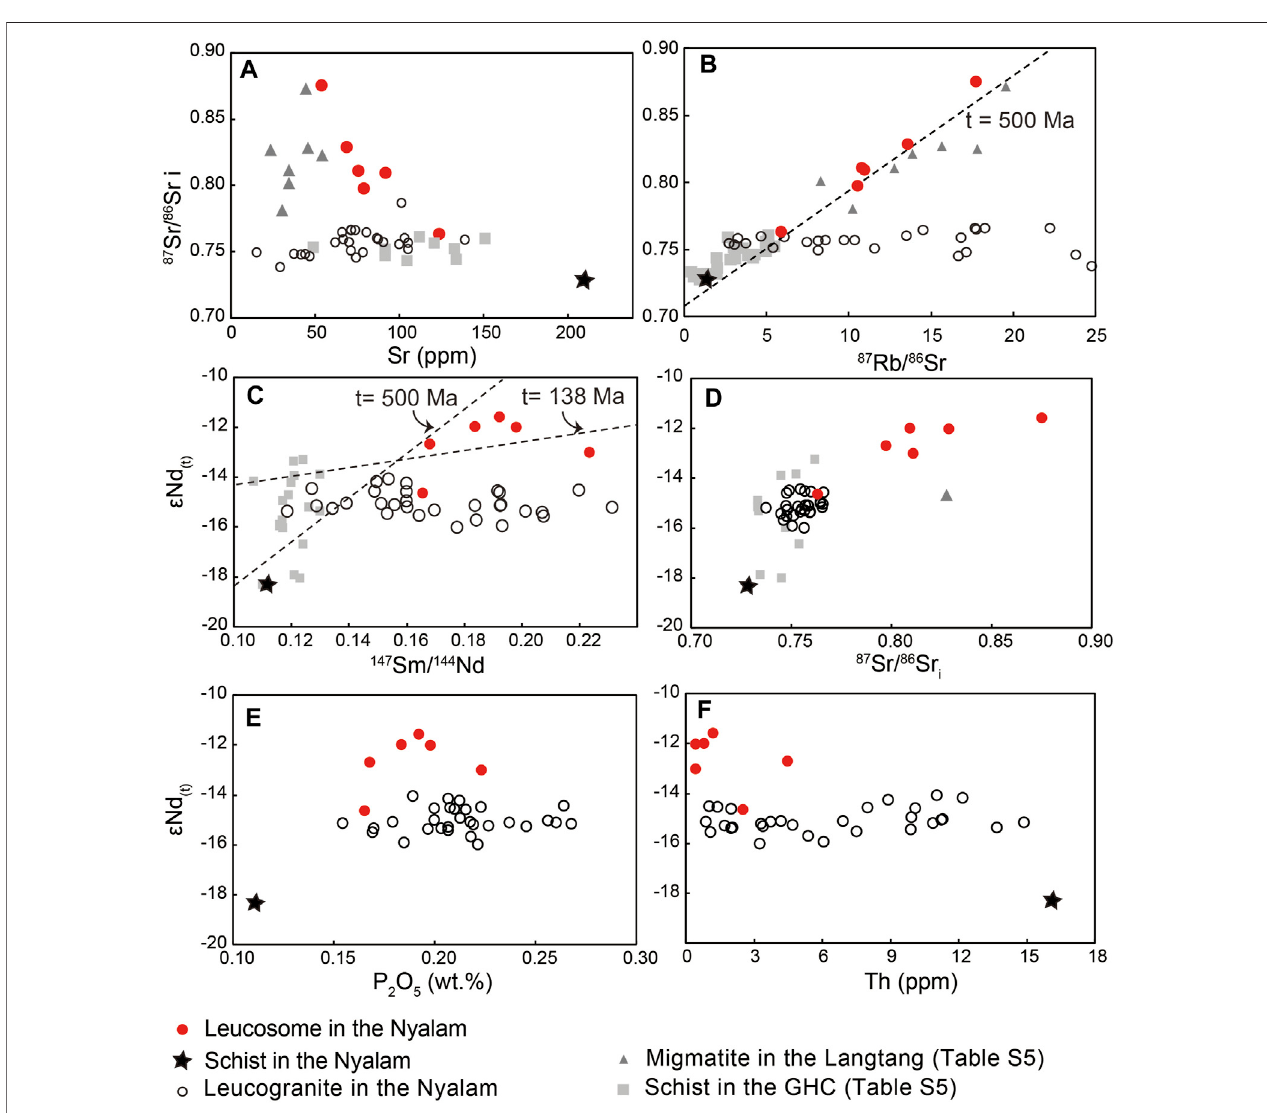
FIGURE5| Plotsof 87 Sr/ 86 Srivs. (A) Srcontent, (B) 87 Rb/ 86 Srratios,and ε Nd(t)vs. (C) 147 Sm/ 144 Ndratio, (D) 87 Sr/ 86 Sr i ratio, (E) P 2 O 5 content,and (F) Thcontent for the Nyalam leucosome, leucogranite, and schist in this study, migmatites in the Langtang (Inger and Harris, 1993), and schists in the GHC (Deniel et al., 1987; Inger